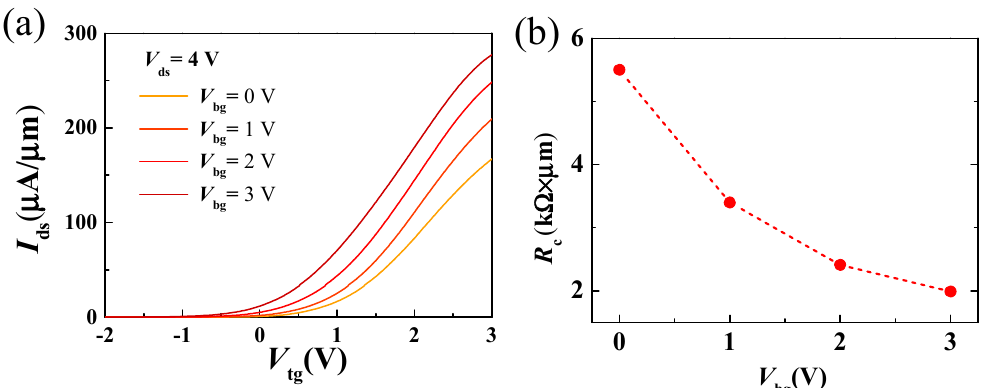
Figure 4. ( a ) Transfer properties of the dual-gate MoS 2 transistors obtained by sweeping the top-gate voltage with varying back-gate biases at V ds = 4 V. ( b ) Extracted contact resistance as a function of back-gate voltage.